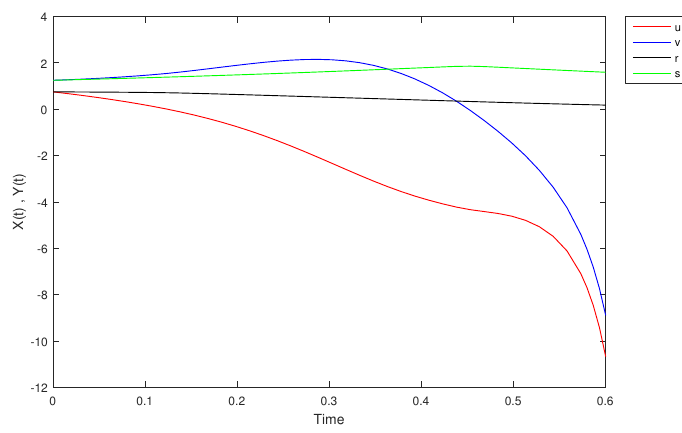
Figure 18. The solution of (10) at α =